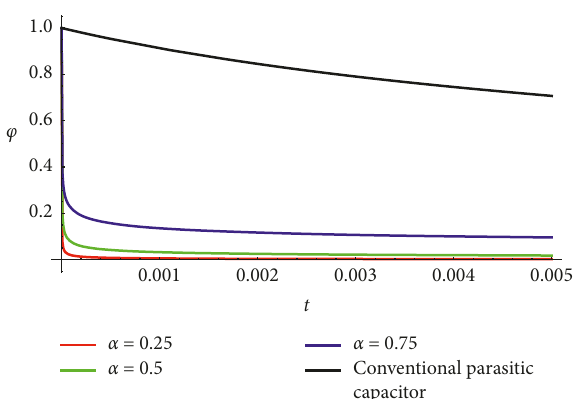
Figure 3: φ vs t of the memristor affected by the parasitic fractional capacitor and by the conventional parasitic capacitor [9].